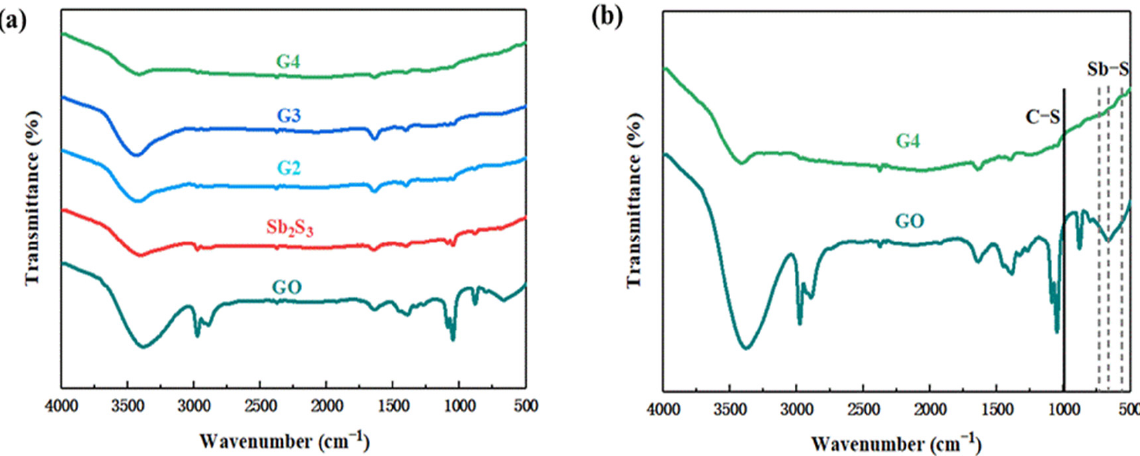
Figure 5. FT − IR spectra of GO, Sb 2 S 3 , and the Sb 2 S 3 /RGO composites G2–G4 ( a ); FT - IR spectra of GO and G4 ( b ). GO and G4 ( b